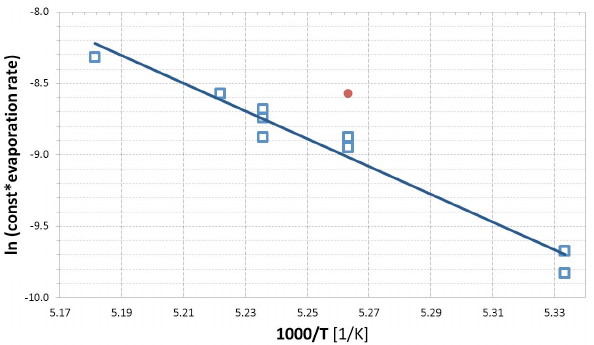
Fig. 5. Arrhenius plot of the rate of change of the IR absorption q of pure HCl 6H 2 O. From the slope ( m =− 9722), one obtains Figure 5. Arrhenius plot of the rate of change of the IR absorption of pure HCl•6H 2 O. From the slope the activation energy E a for HCl sublimation in HCl (m = -9722), one obtains the activation energy E a for HCl sublimation in HCl•6H 2 O of 80.8 ± 5.8 kJ of 80.8 ± 5.8kJmol − 1 leading to log J ev /moleccm − 2 s − 1 = mol -1 leading to logJ ev /molec cm -2 s -1 = (36.3 ± 3.2) – (80.8 ± 5.8)/2.303RT; R = 8.314 JK -1 mol -1 (36.3 ± 3.2) − (80.8 ± 5.8)/2.303 RT ; R = 8.314 JK − 1 mol − 1 without taking into account the outlier (red circle). The evaporation rate of HCl has been multiplied without taking into account the outlier (red circle). The by log(e) σ (3426 cm -1 ) = 1.0 x 10 20 cm 2 molec -1 (ordinate). evaporation rate of HCl has been multiplied by log(e) σ (3426m − 1 ) = 1.0 × 10 20 cm 2 molec − 1 (ordinate).